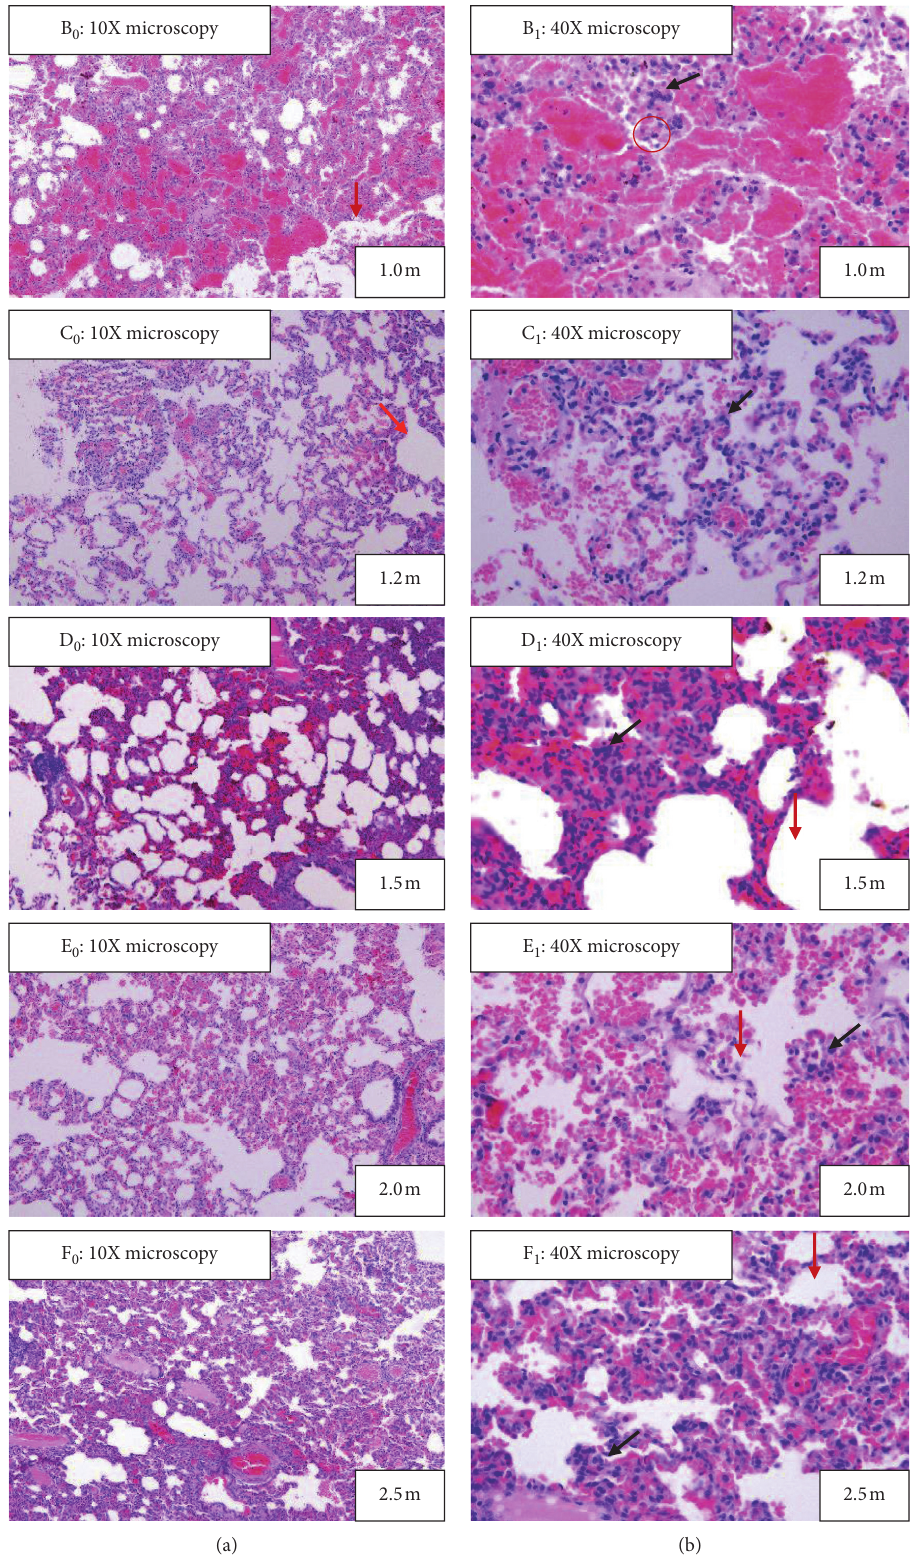
Figure 6: HE-stained photos of blast-injured lung tissue cells with varying distance to the explosion center. (a) 10X magnification and (b) 40X magnification. B, 1.0m from explosion center; C, 1.2m; D, 1.5m; E, 2.0m; F,